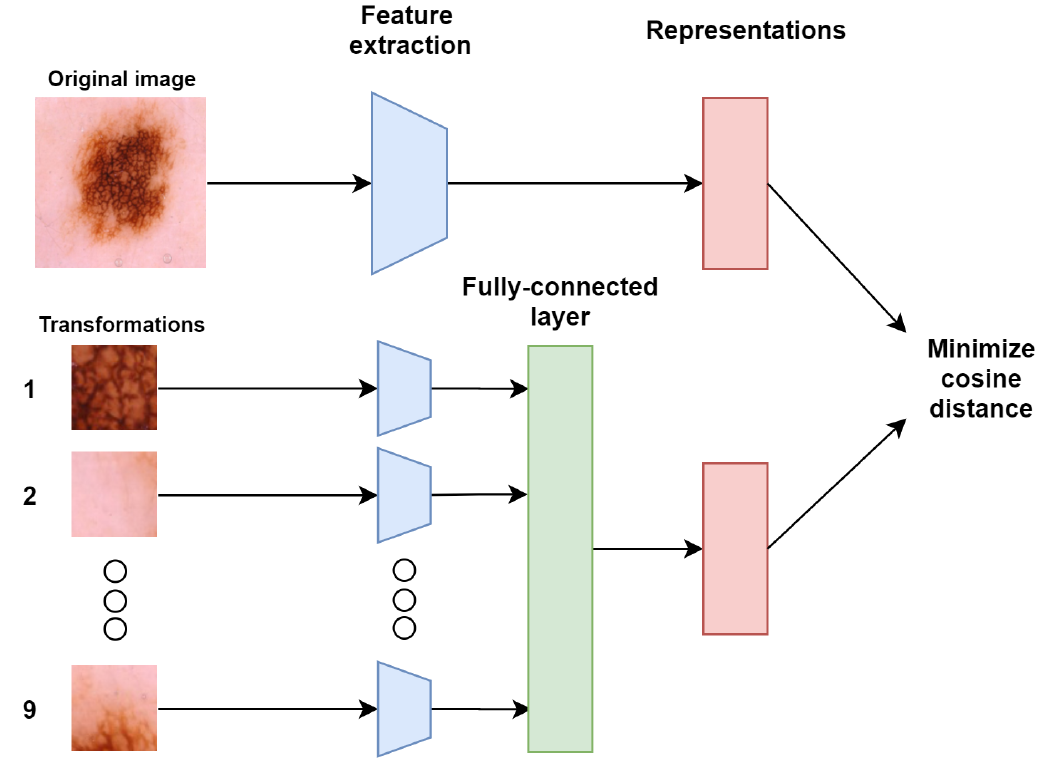
Figure 3. Jigsaw pretext task